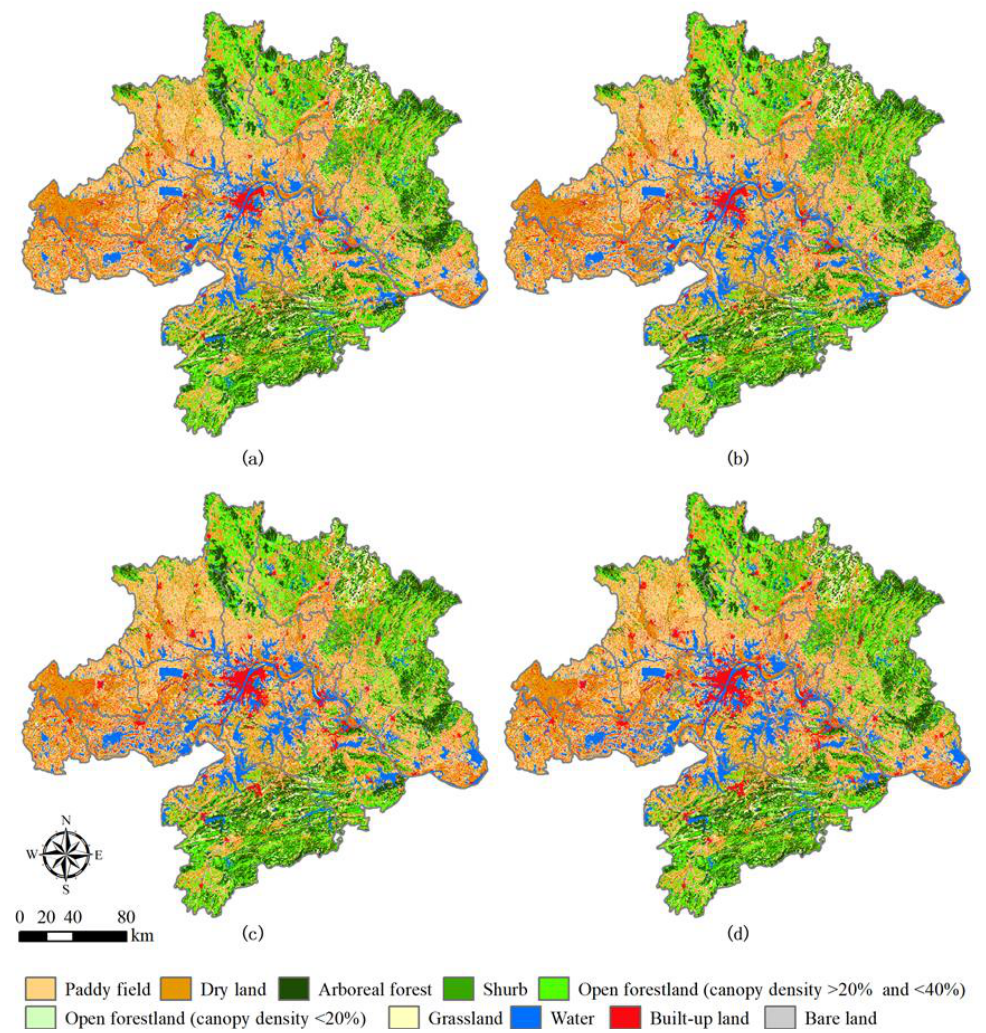
Figure 5. Spatial explicit land use maps of the Wuhan City Circle area in 2000 ( a ), 2005 ( b ), 2010 ( c ) and 2015 ( d ).